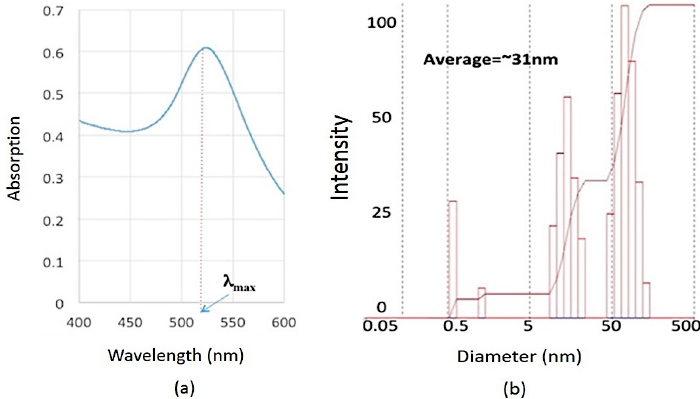
Figure 2. GNPs characterization results using ( a ) UV-Vis absorption spectroscopy; ( b ) DLS technique.